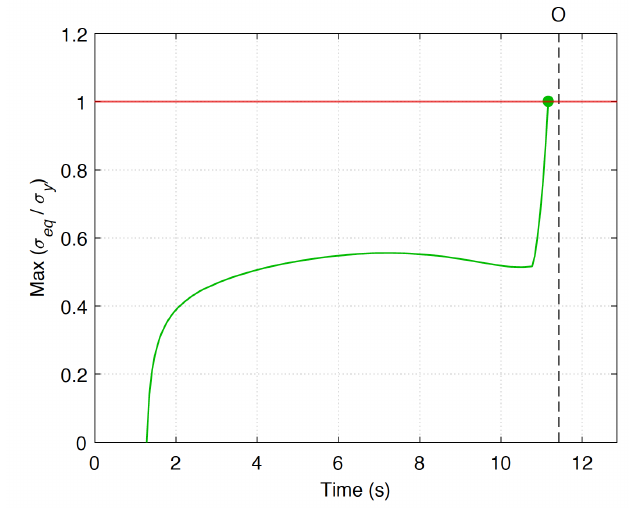
Figure 20. Numerical detection of the beginning of plasticity.